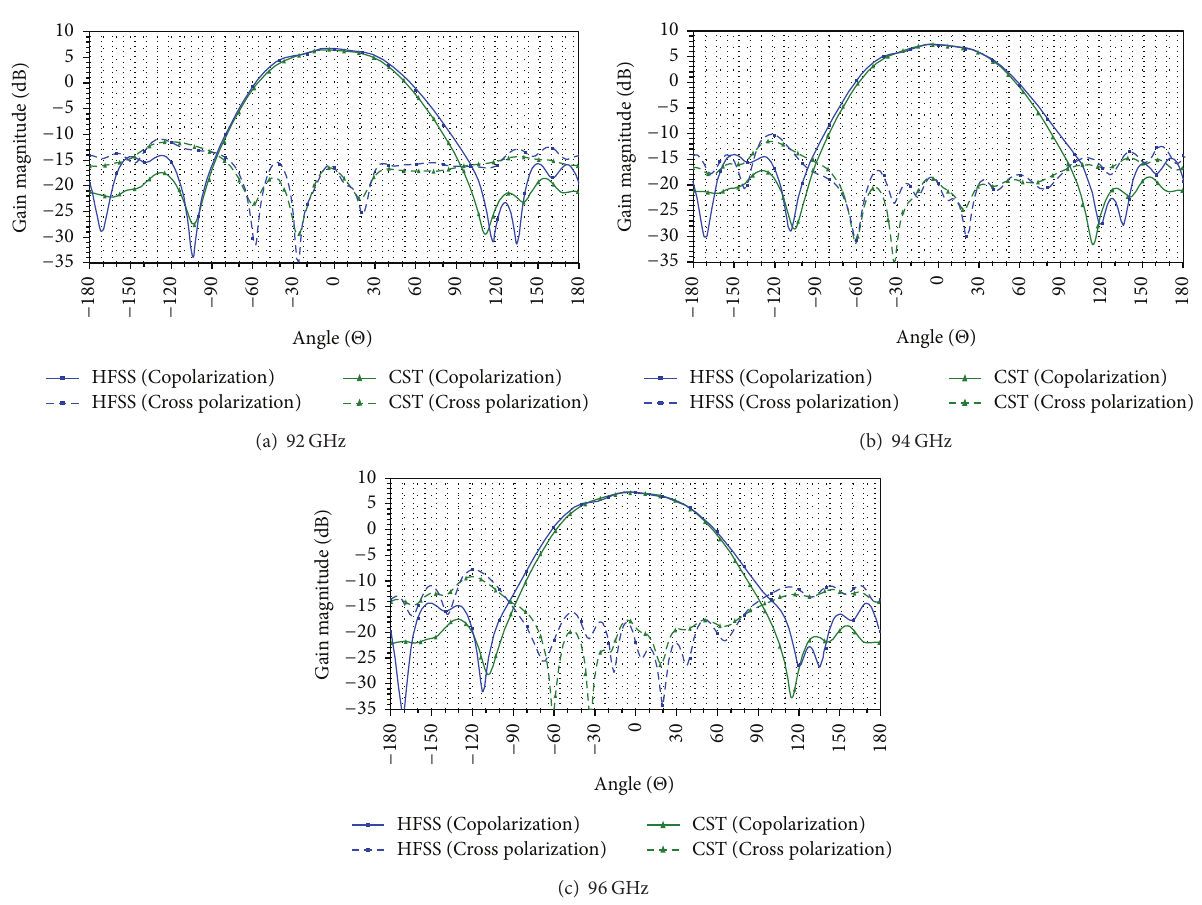
Figure 5: 2D radiation pattern in H-plane with co- and cross